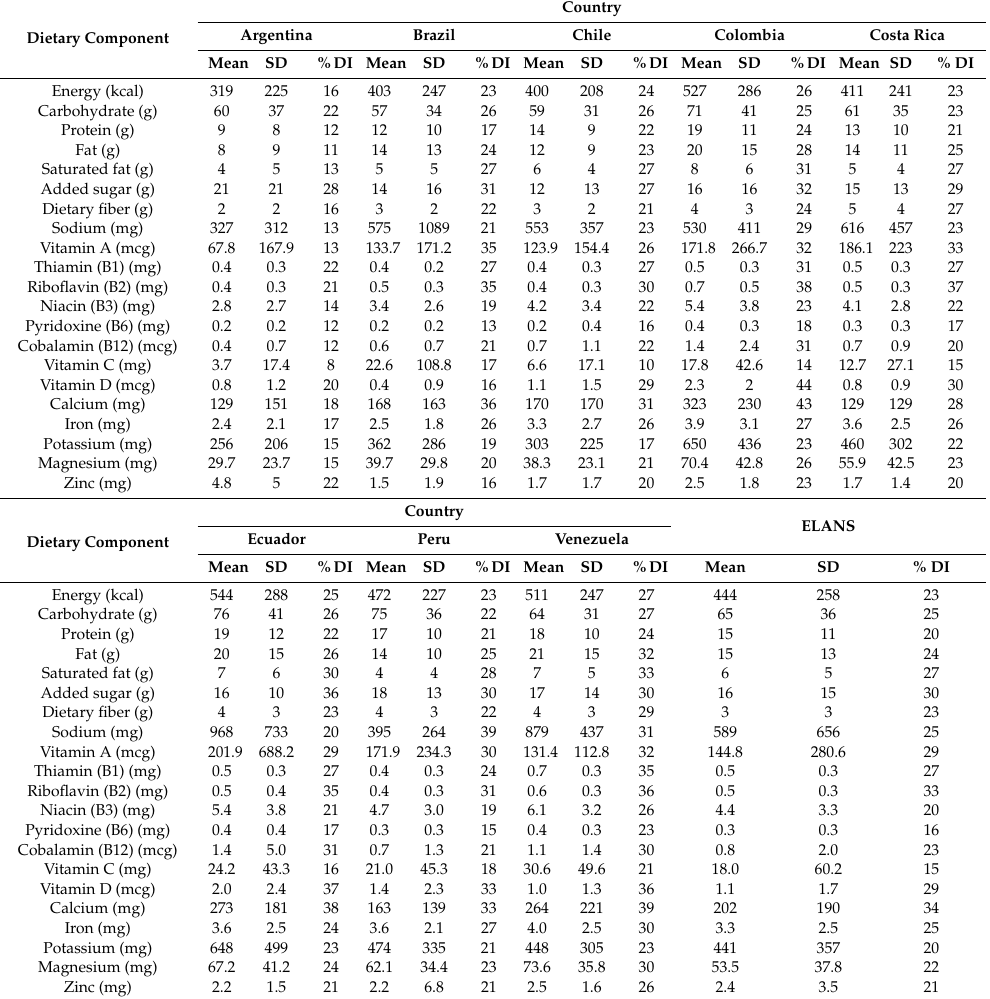
Table 2. Mean (SD) breakfast intake and contribution to daily intake (%) of energy, fiber and micronutrients of occasional ( n = 1467) and regular ( n = 7247) breakfast consumers, by country. Country Brazil Dietary Component Energy (kcal)